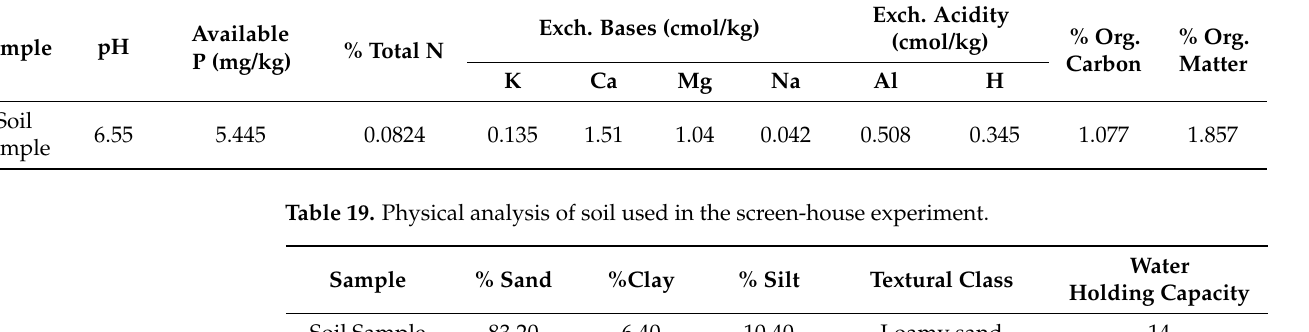
Table 18. Chemical analysis of soil used in the screen-house experiment.